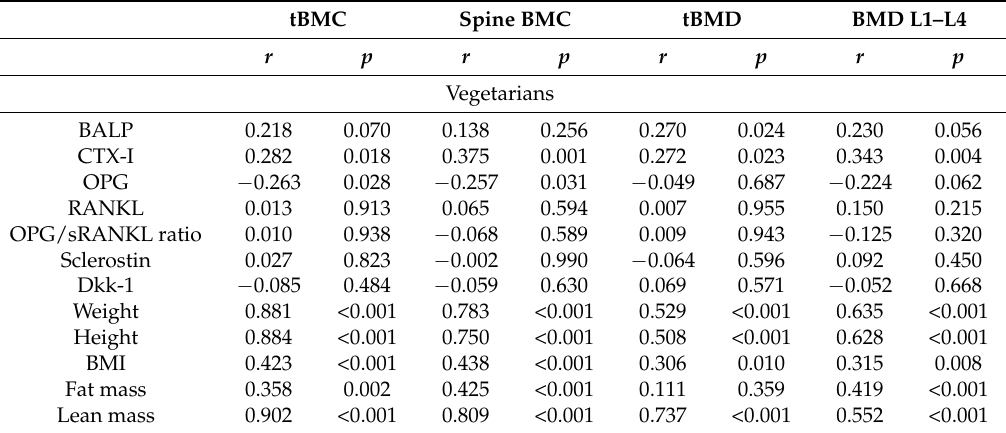
Table 3. Correlations between bone mineral content as well bone mineral density and biochemical or anthropometric parameters in children on vegetarian and omnivorous